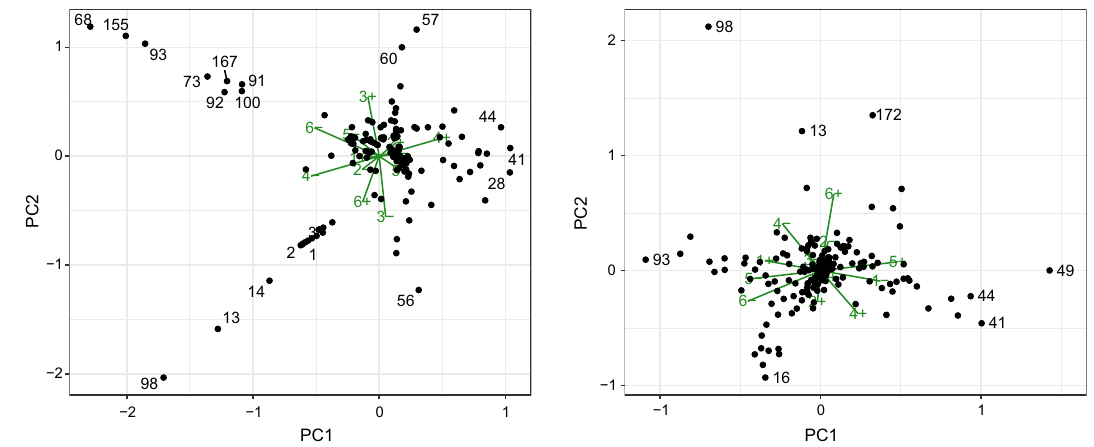
Fig. 8 Observables in the space of principal components obtained by performing PCA on the distributions in δ (left) and δ σ (right). The green arrows illustrate the projection onto the first principal components and are labeled by direction in δ space. They indicate how the original parameters relate to the projection